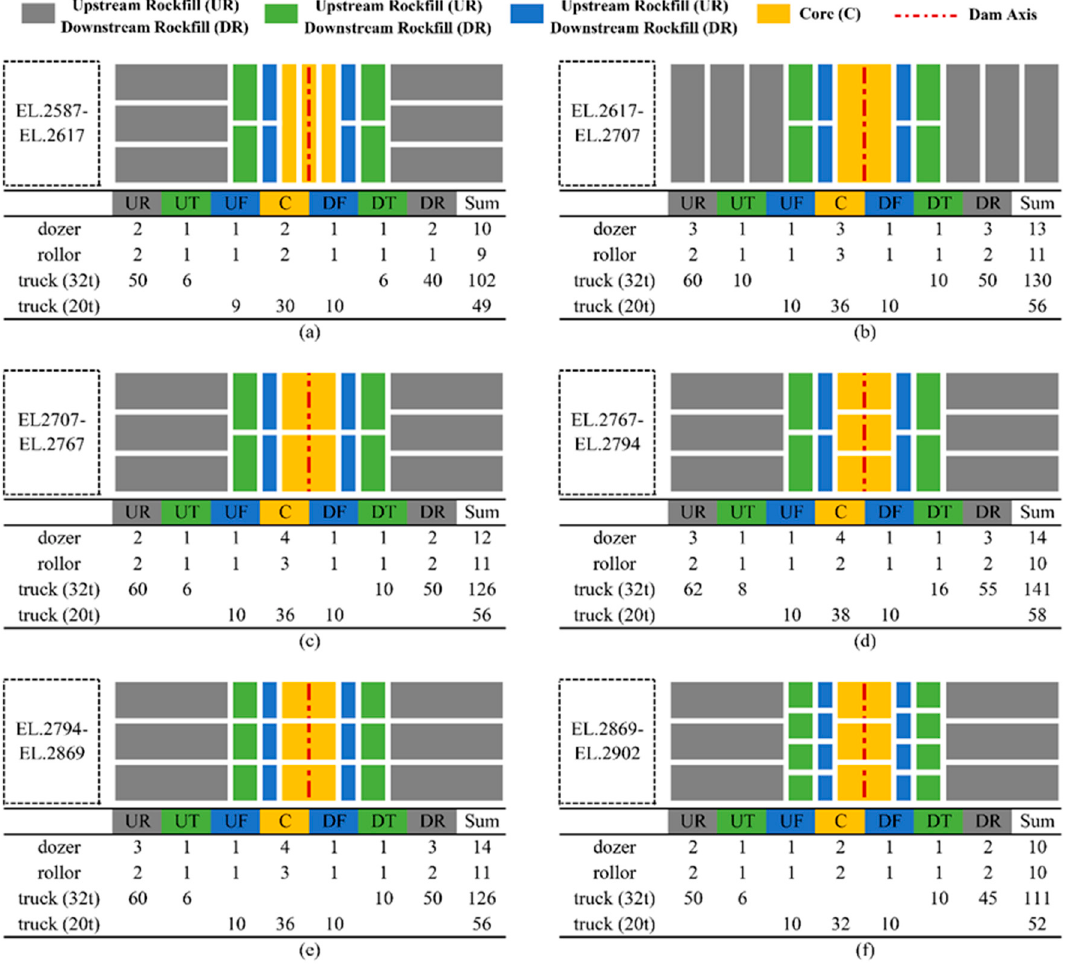
Figure 10. Results of the flow shop construction scheme MCDM. ( a ) Optimal flow shop at Elevation 2587–2617; ( b ) Optimal flow shop at Elevation 2617–2707; ( c ) Optimal flow shop at Elevation 2707–2767; ( d ) Optimal flow shop at Elevation 2767–2794; ( e ) Optimal flow shop at Elevation 2794–2869; ( f ) Optimal flow shop at Elevation 2869–2902.